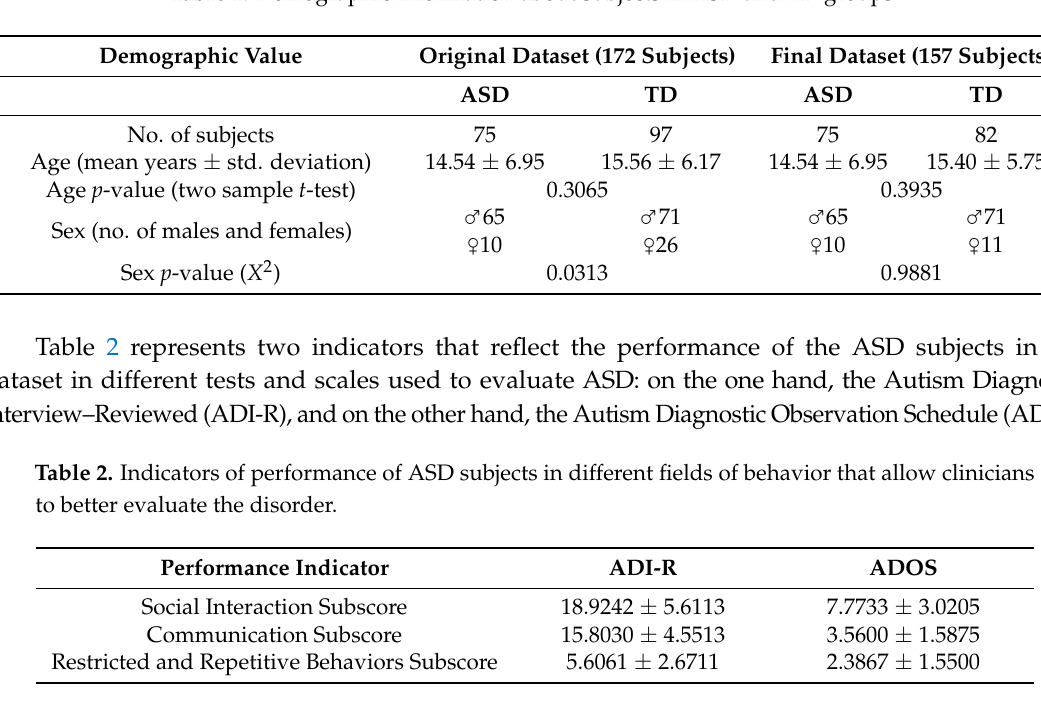
Table 1. Demographic information about subjects in ASD and TD groups.